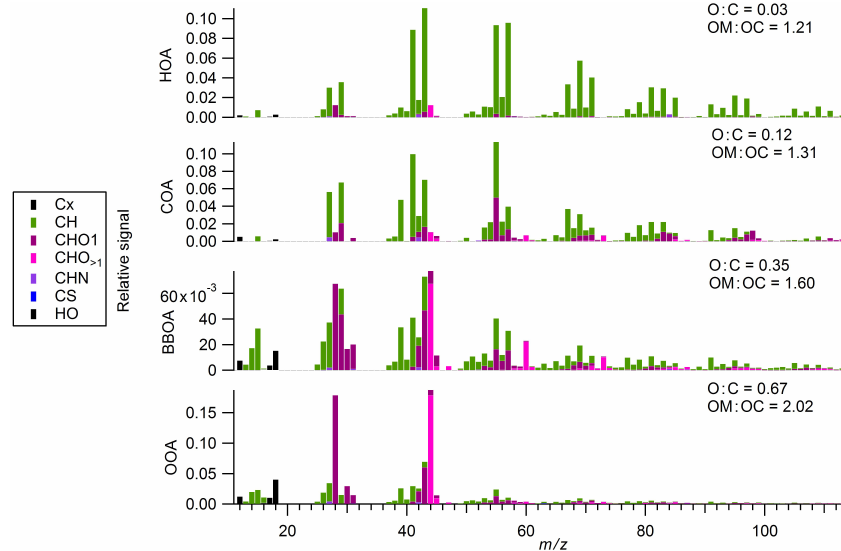
Figure 2. Online-AMS: average PMF factor mass